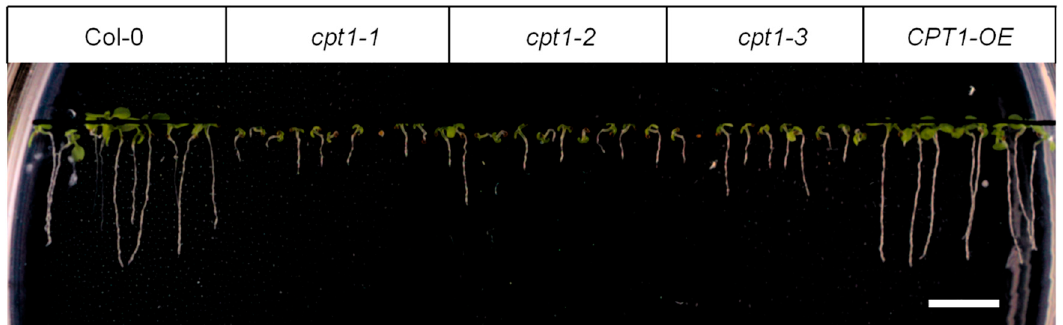
Figure 3. Growth phenotype of AtCPT1 mutants. The wild type (Col-0), T-DNA insertion mutants ( cpt1-1 , cpt1-2 and cpt1-3 ) and AtCPT1 overexpressing ( CPT1-OE ) Arabidopsis seedlings were grown for seven days on vertically oriented agar plates. Scale bar = 1 cm. Representative data are shown.